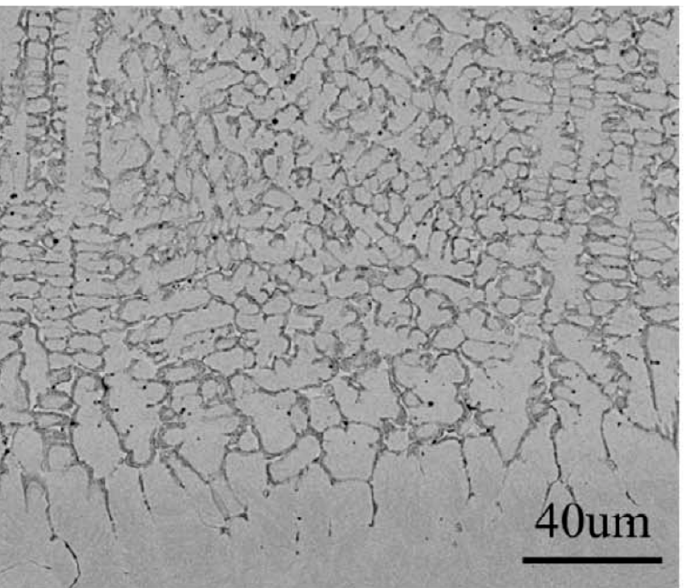
Figure 11. SEM micrograph through the entire FeCoNiAlCuSi HEA plasma cladded coating. Micro- graph is reprinted with permission from ref. [96]. Copyright 2017 Elsevier.